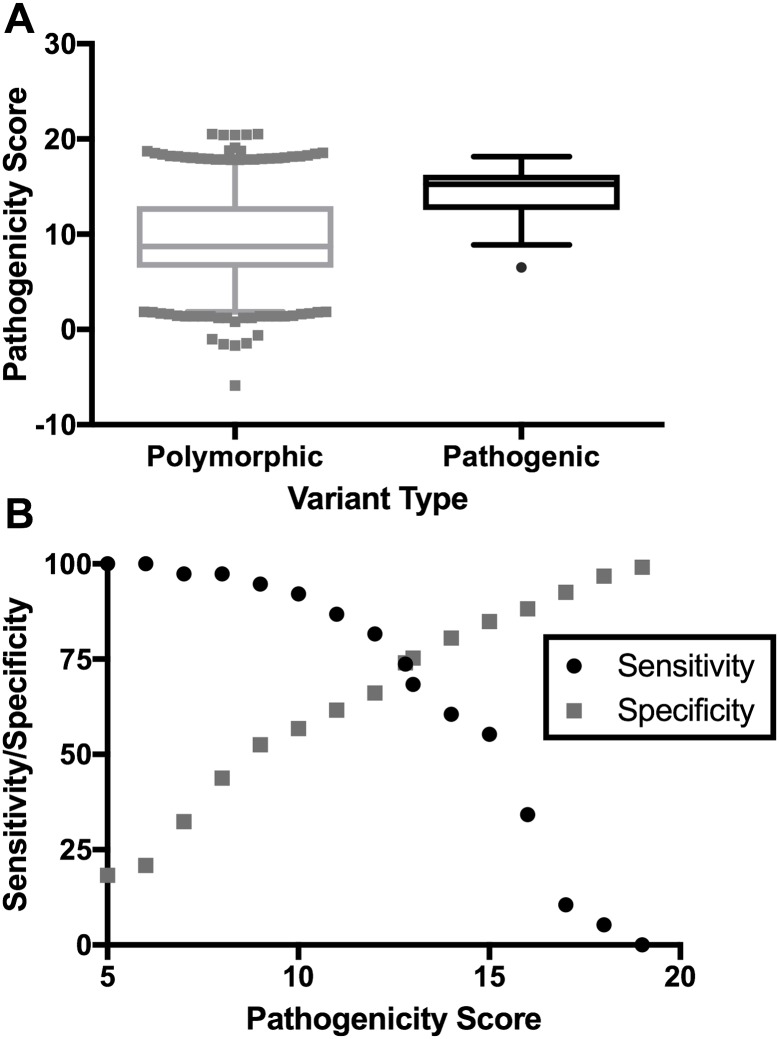
Separation of benign and pathogenic variants by MitoTIP.(A) Pathogenicity scores from naïve evaluations of known pathogenic (n = 38) and described benign (n = 651) variants plotted using box and whiskers at 5–95% (p<0.0001 by Mann Whitney test). Negative scoring is possible when polymorphisms improve Watson-Crick pairing in stems. (B) Sensitivity and specificity plot of these data at a range of pathogenicity scores. The crossover pathogenicity score was 12.8.